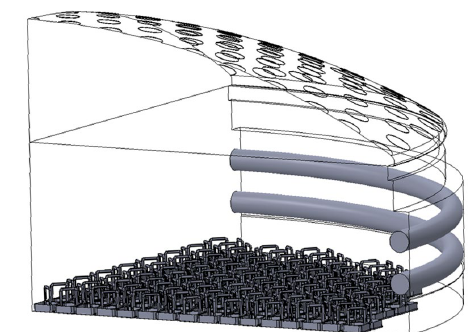
Fig. 1. 3D view of CFD model showing steam separator, top guide, grid beam, spargers, and fuel